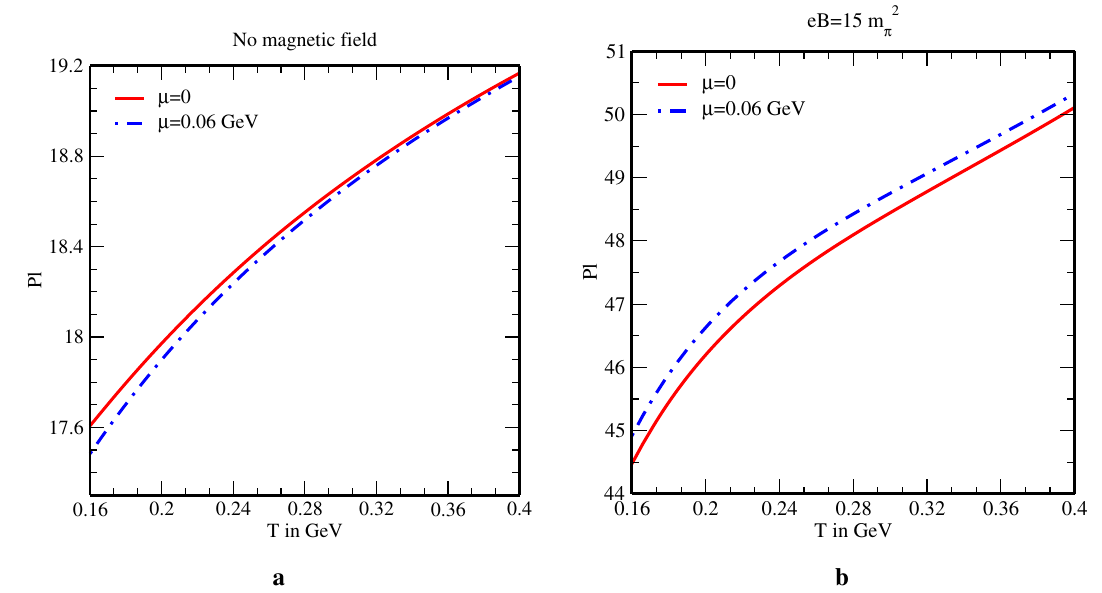
Fig. 5 Variations of the Prandtl number with temperature in the a absence and b presence of strong magnetic field